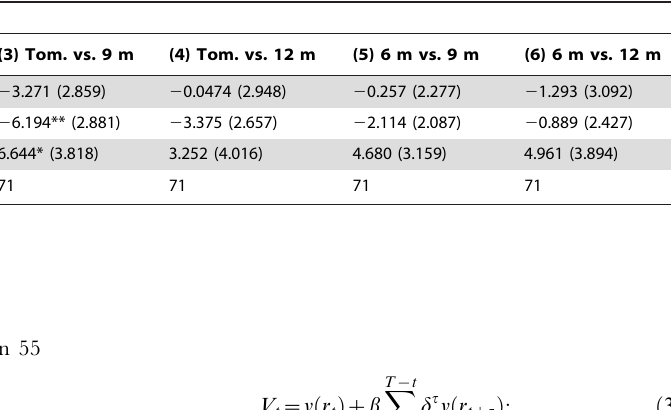
Table 7. Effect of stress manipulation on indifference points in intertemporal choice task for impatient subjects only.